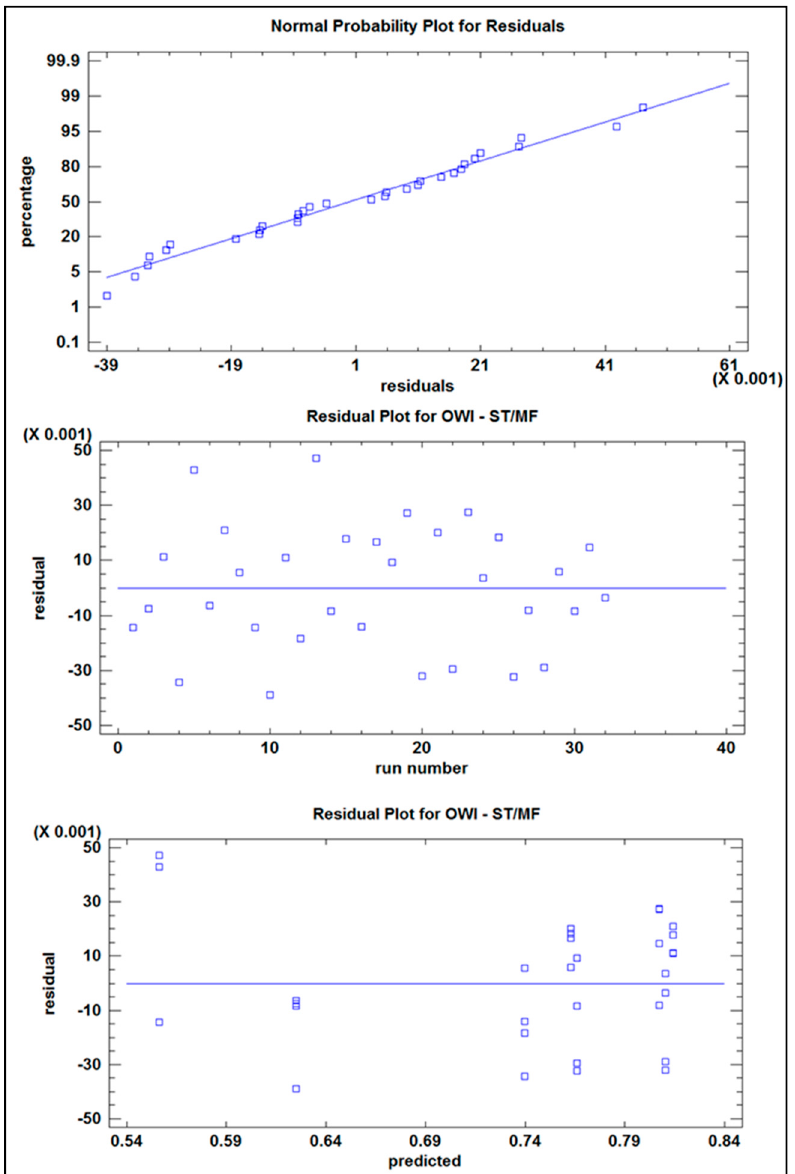
Figure 5. Graphic verification of Homoscedasticity, Normality, and Independence—Experiment 2 k .